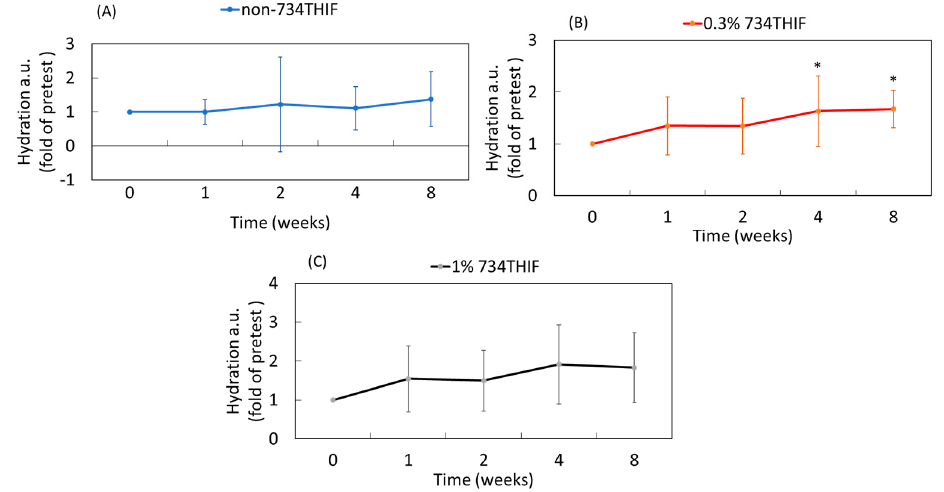
Figure 11. The skin surface hydration in 21 volunteers before and after treatment with different concentrations of 734THIF of 5-7HP formulation at different times. ( A ) non-content of 734THIF, ( B ) 0.3% 734THIF and ( C ) 1% 734THIF ( n = 7 in each group; * p < 0.05 compared with the group of zero weeks).